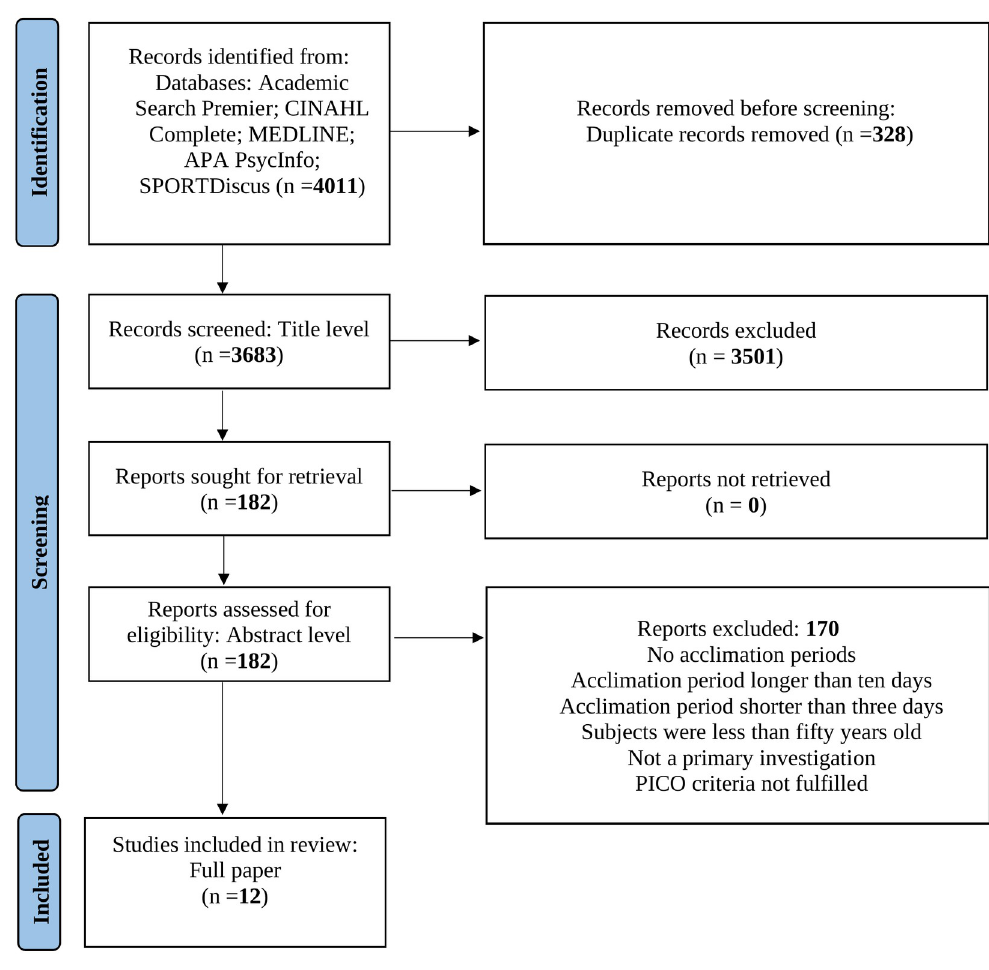
Fig 1. PRISMA flow